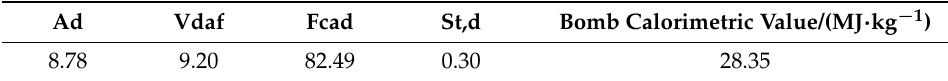
Table 2. Composition of the coal (%, mass fraction) where Ad = dry basis ash; Vdaf = volatile dry